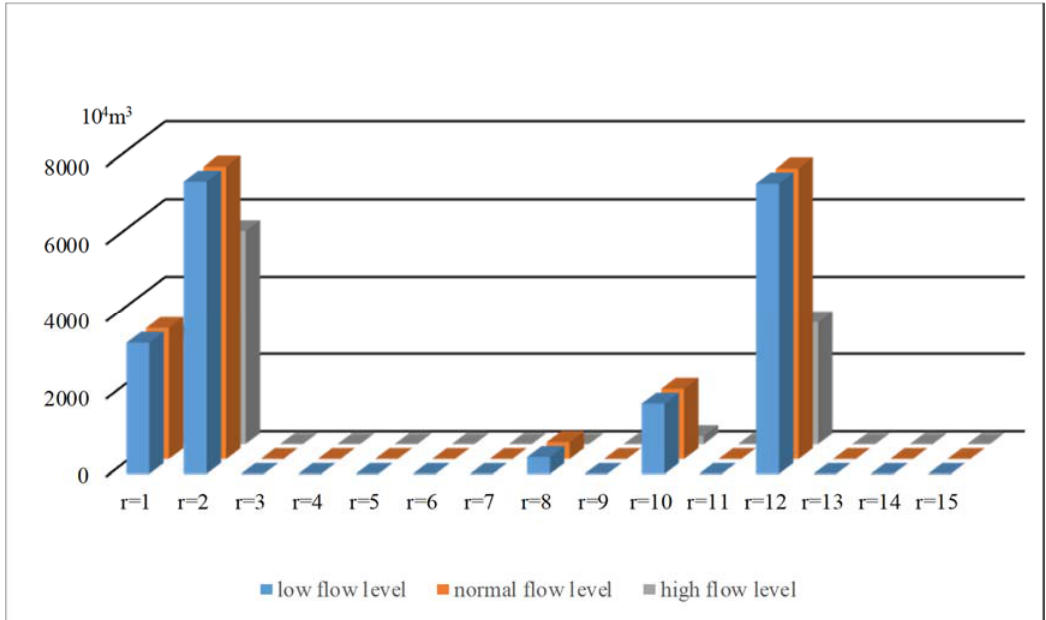
Figure 9. Water diversion schemes of normal supplementation resources under different levels.